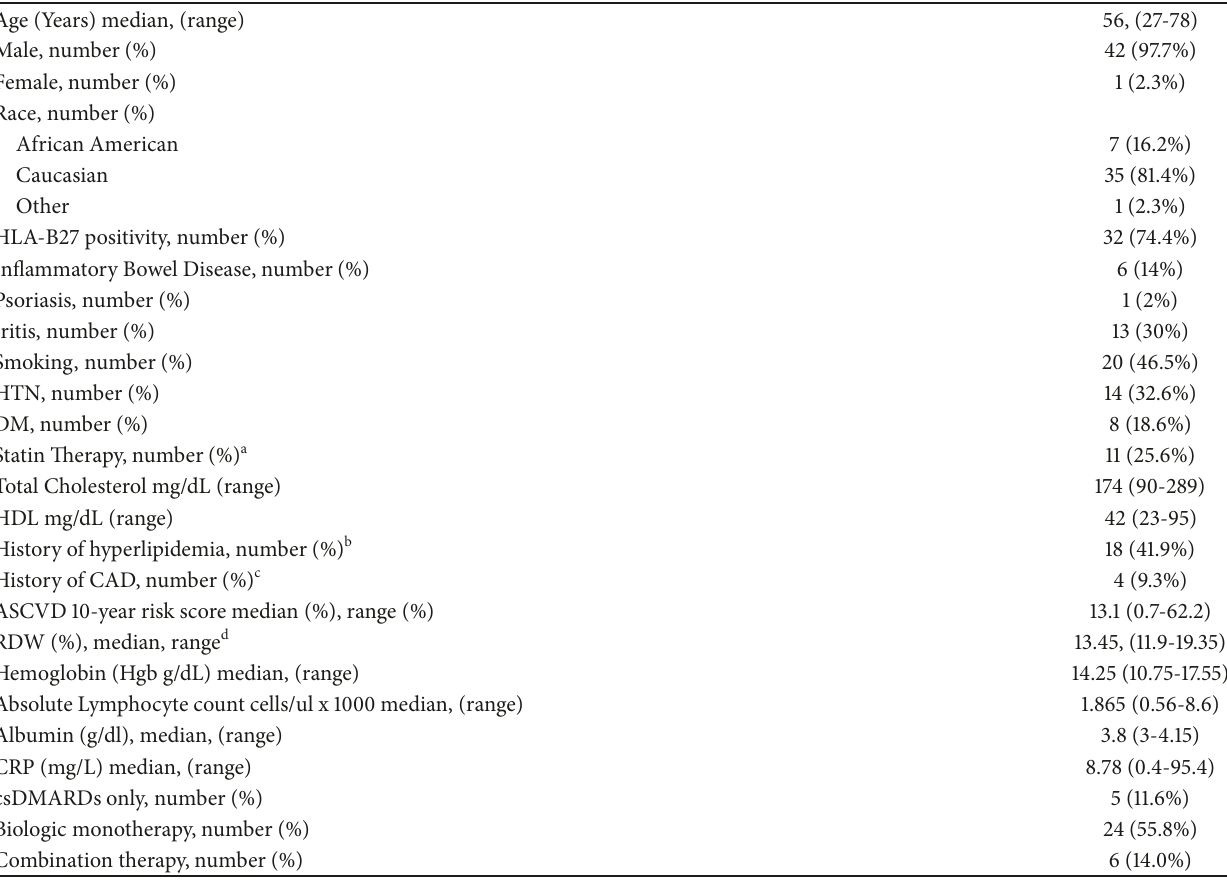
Table 1: Characteristics of patient